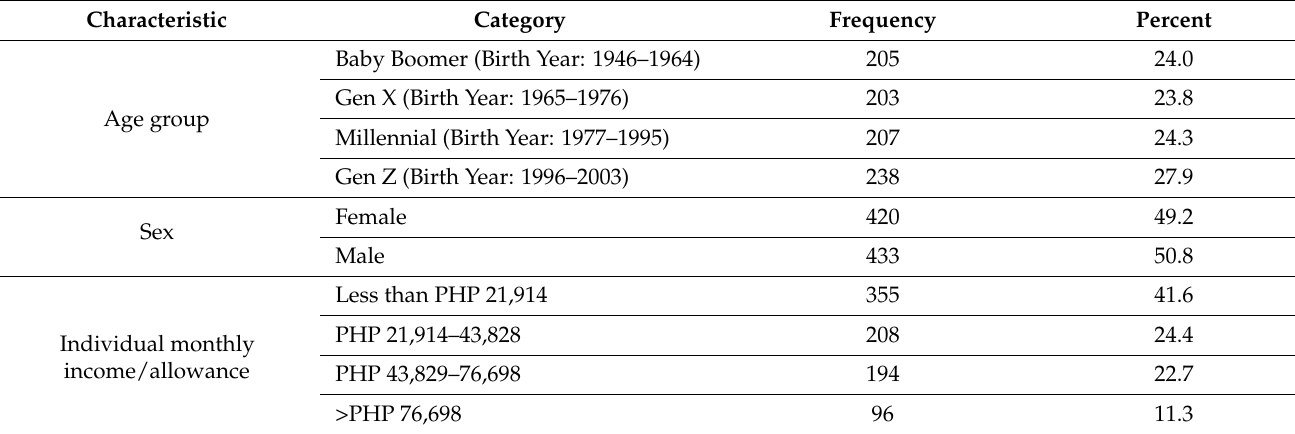
Table 3. Demographic profile of the